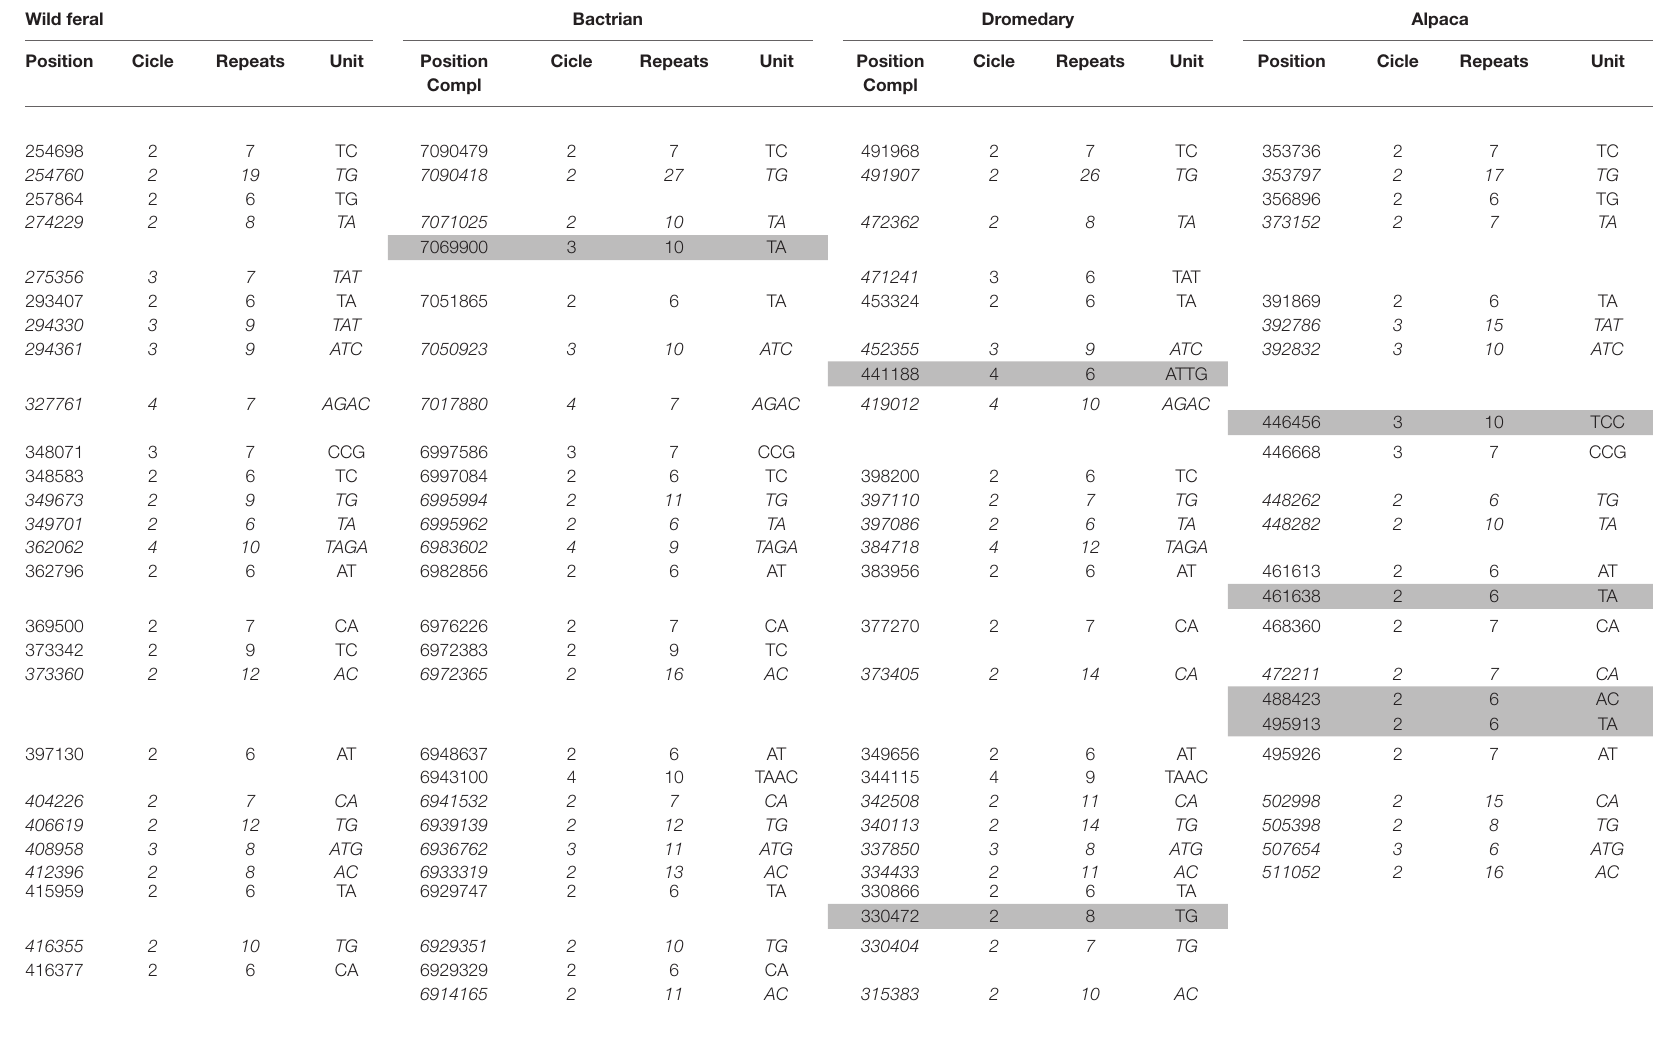
TABLE 4 | List of microsatellites found in the casein cluster of camelids. Short tandem repeats polymorphic among the species are in italics. Species-specific microsatellites correspond to gray cells. Positions are indicated according to the corresponding GenBank sequence (wild feral: AGVR01039100.1; Bactrian: NW_011517196.1; dromedary: NW_011591251; alpaca: KN269544); therefore, they are complementary (Compl) for Bactrian and